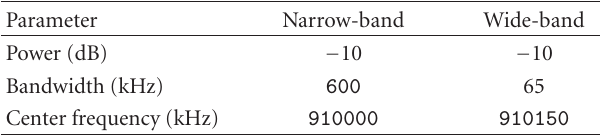
Table 6: Configuration parameter initial settings.